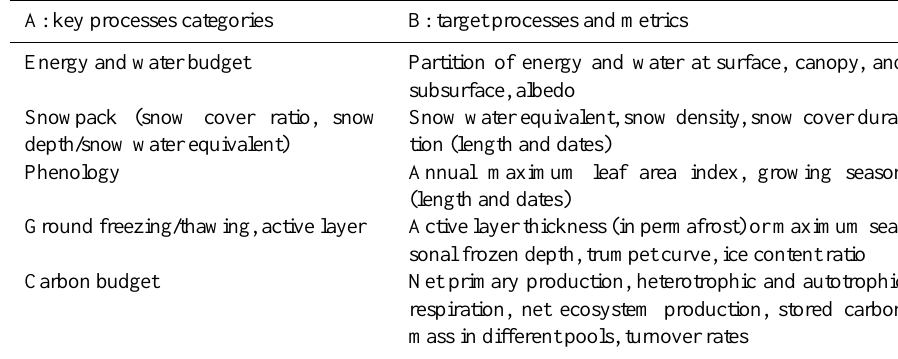
Table 1. The key process categories and target processes. A: key processes